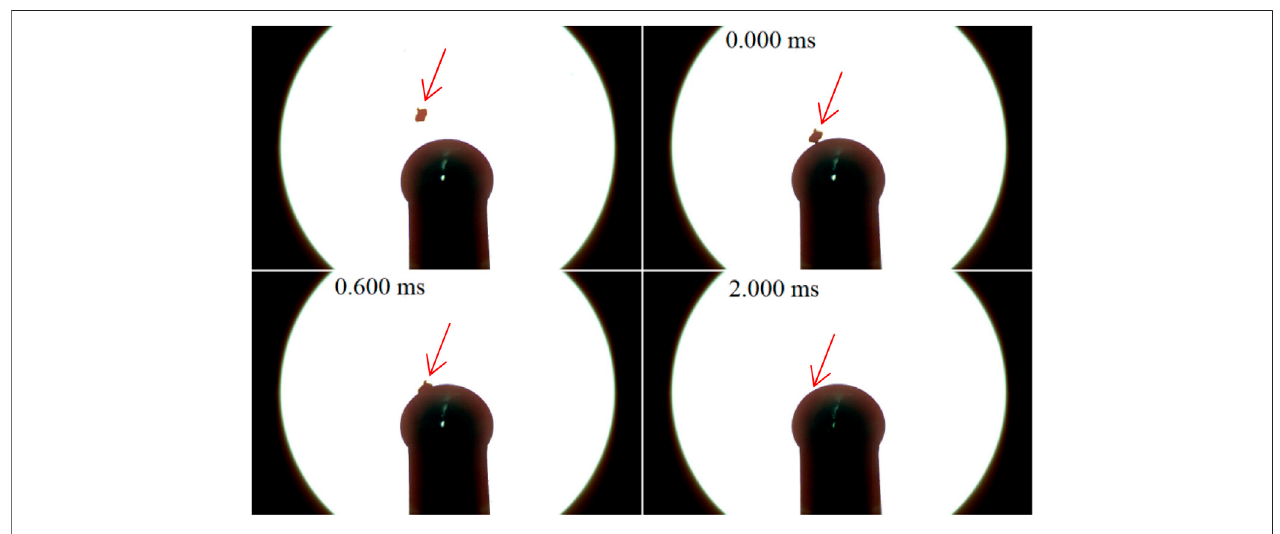
FIGURE 9 | Blasting demolition dust and municipal water droplets collision results.